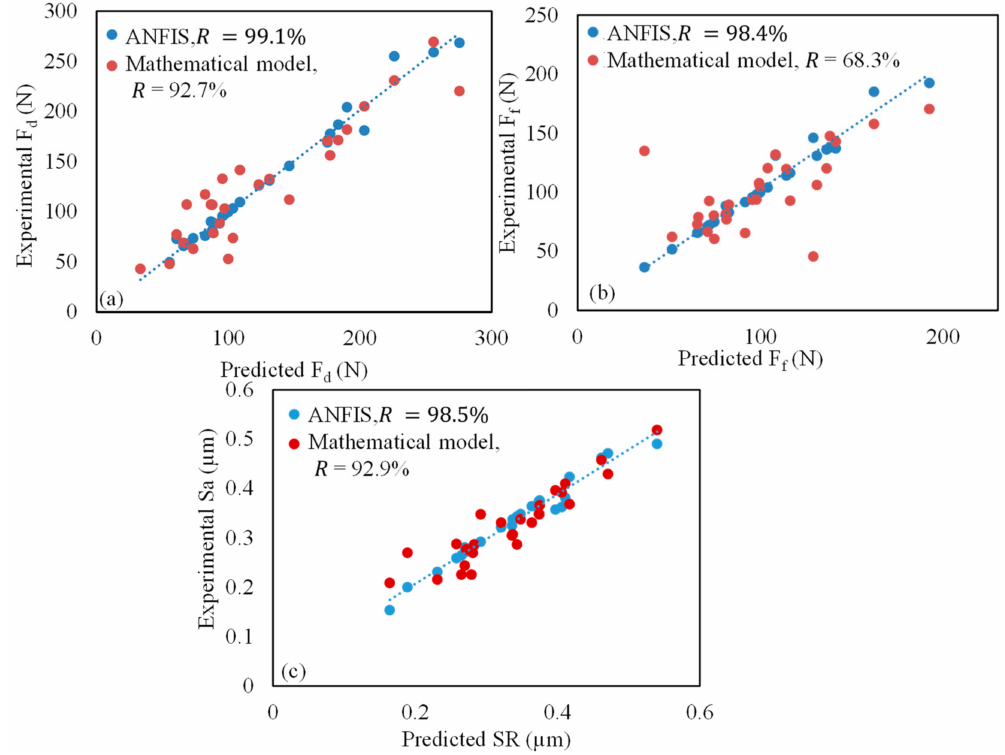
Figure 8. Predicted value of experimental vs. ANFIS vs. mathematical models on output responses; ( a ) depth force; ( b ) feed force; ( c ) surface